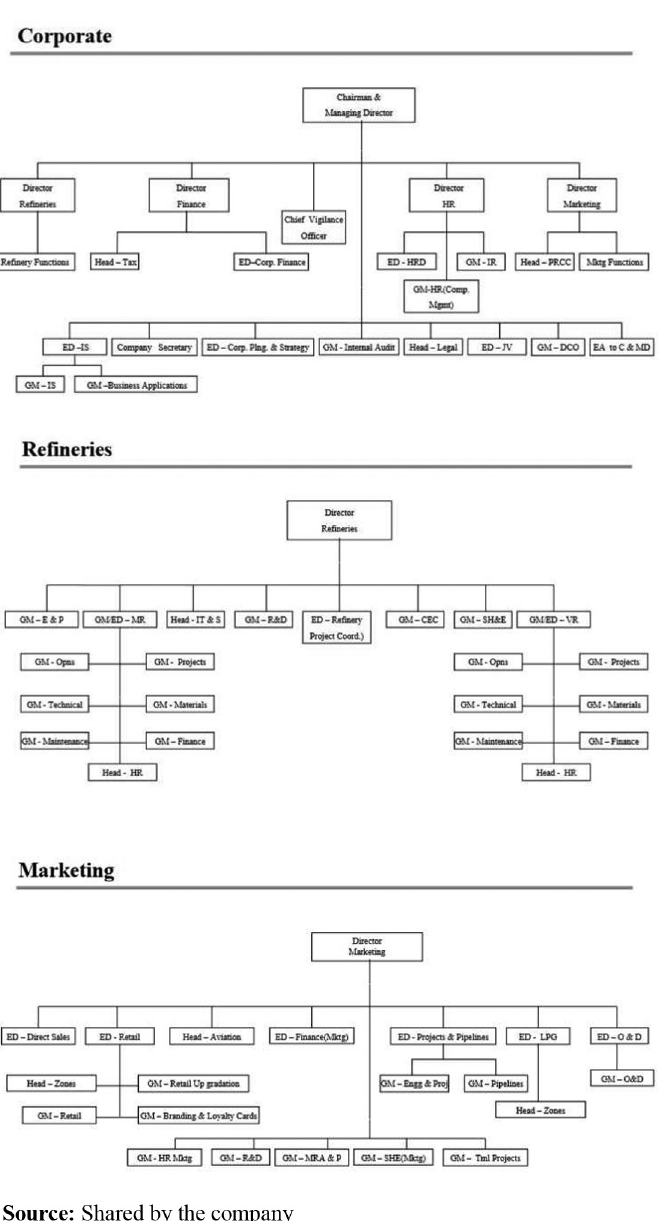
Figure E1. Organization structure of ABC Ltd. at corporate, re fi neries